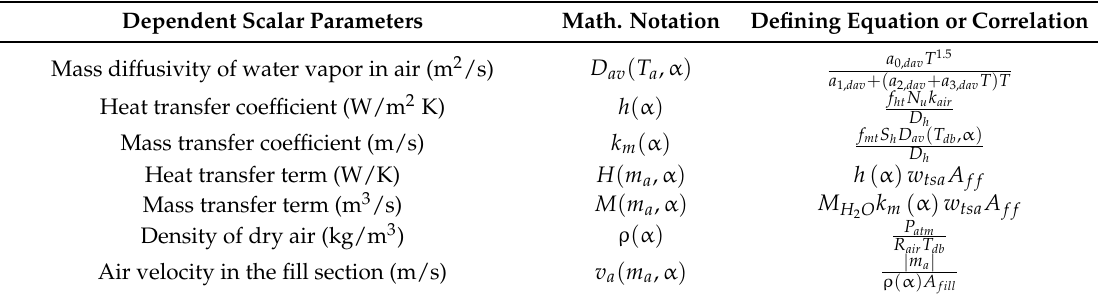
Table B2. Dependent Scalar Model